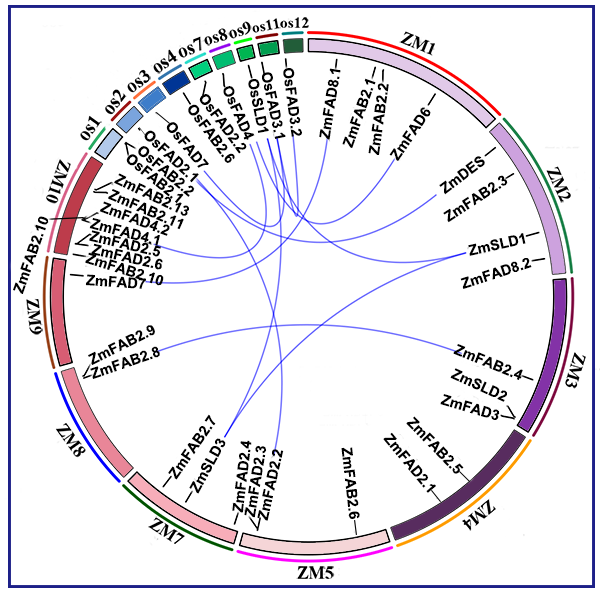
Figure 3. Syntenic analysis of FAD genes from maize and rice. The chromosomes are described as a circle. The colored segments represent the syntenic relationship among the FAD and the FAB2 genes.